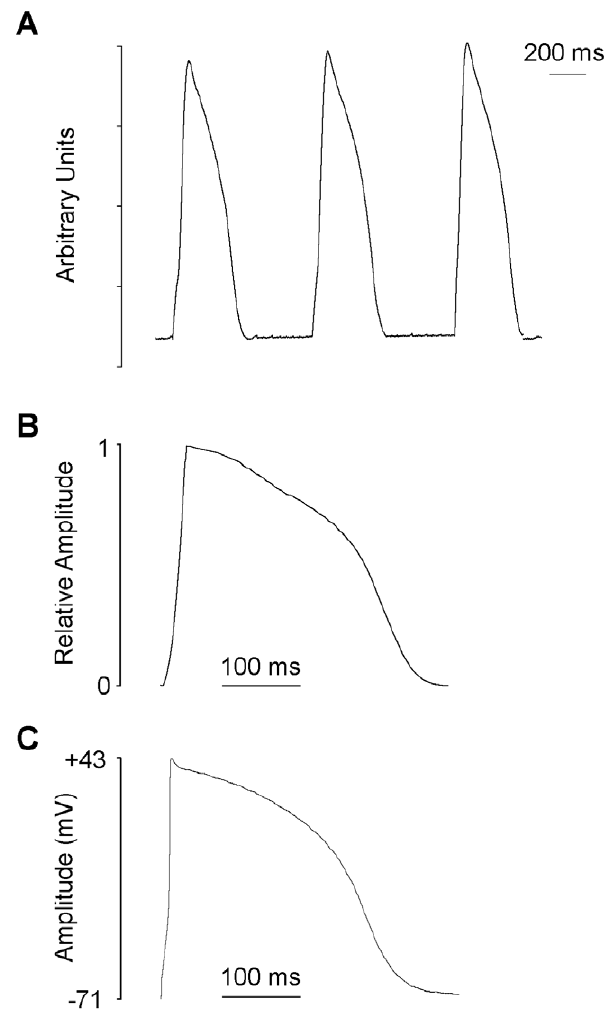
Figure 1. MAPs recorded from fish ventricular myocardium. (A) A train of MAPs recorded from trout ventricular myocardium paced at 0.8 Hz at 11 u C. (B) A single MAP taken from the surface of a trout heart spontaneously beating at 0.4 Hz. (C) Current-clamp recording of an AP from an isolated trout ventricular myocyte paced at 0.4 Hz (courtesy of R. Birkedal). The repolarisation time course of the AP and the MAP are similar. The y-axis of the MAP has been scaled to facilitate the comparison of AP/MAP time courses.